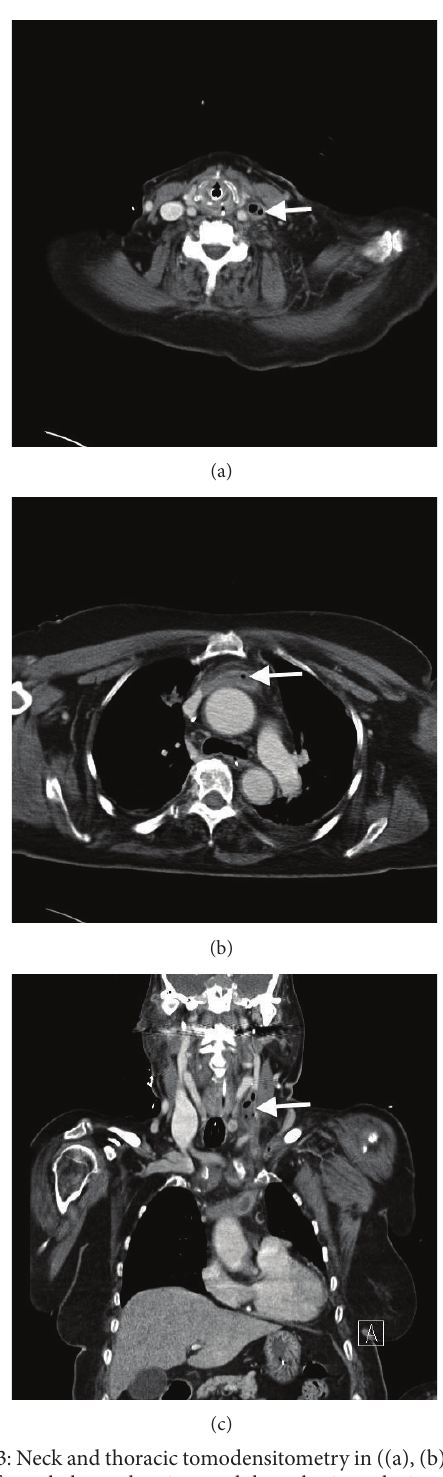
Figure 3: Neck and thoracic tomodensitometry in ((a), (b)) coronal and (c) frontal planes showing total thrombotic occlusion of the left internal jugular vein extending to the innominate vein and partially involvingtheleftsubclavianvein,withairbubbleswithinit(arrows).